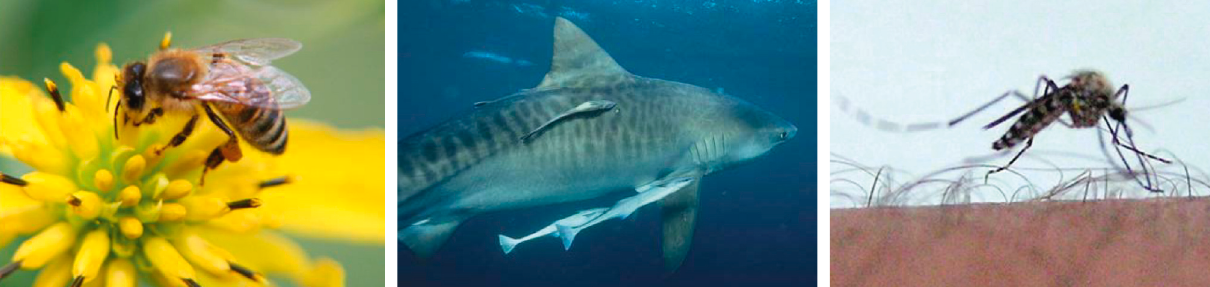
Figure 1: Symbiotic relationships (mutualism, commensalism, and parasitism) among organisms in an